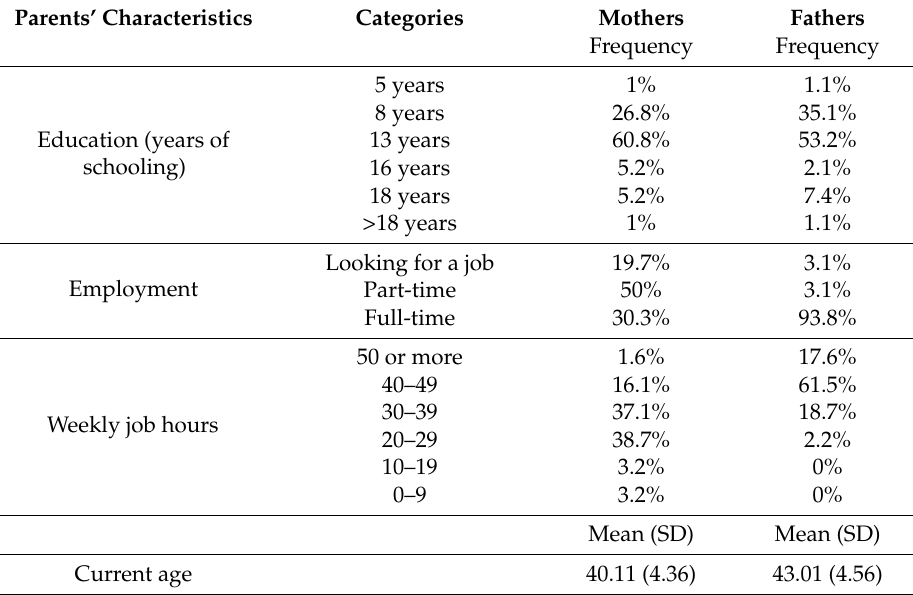
Table 2. Family’s sociodemographic